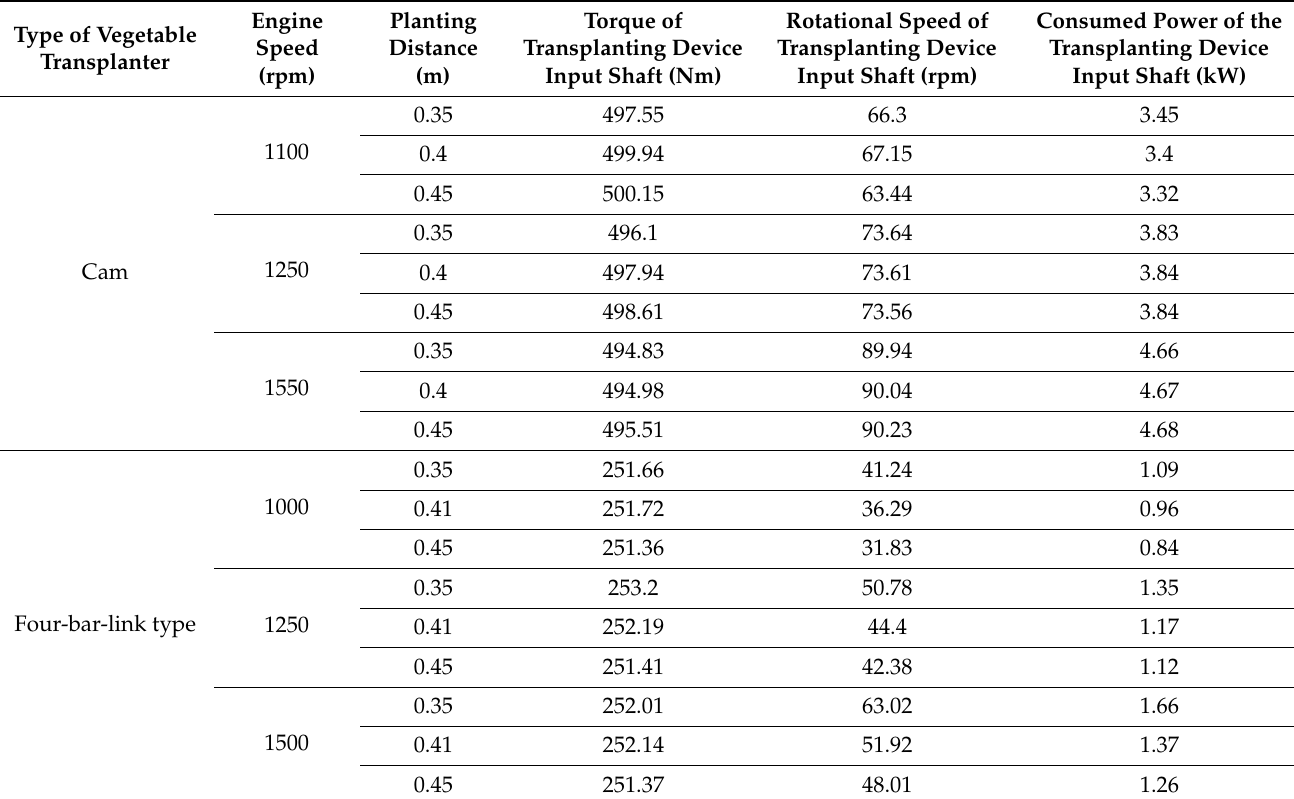
Table 4. Torque, rotational speed, and consumed power of the transplanting device input shaft under different working